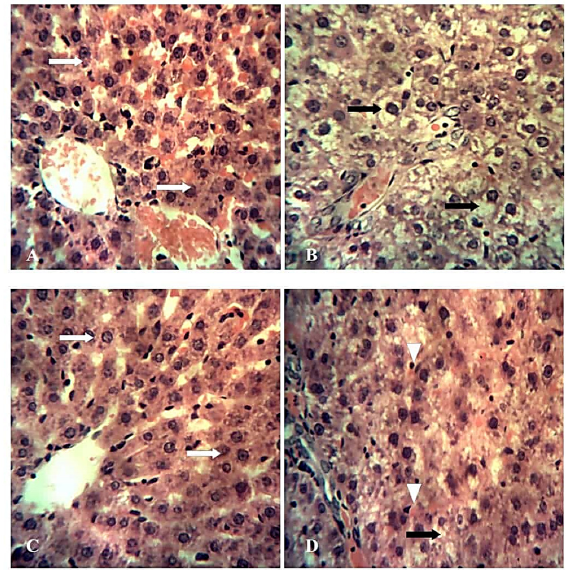
Figure 1. Photomicrograph of the liver from groups A (control) and C (500mg/kg HMETV) showing apparently normal hepatocytes (white